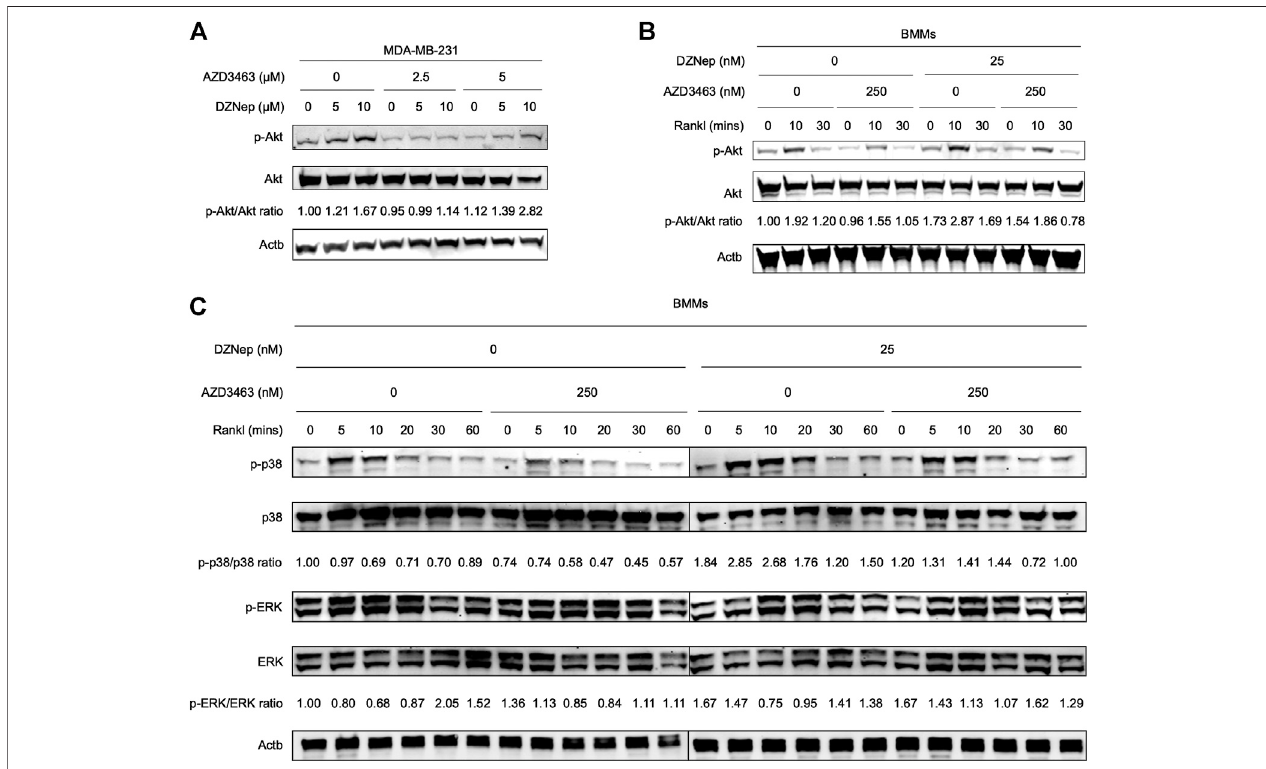
FIGURE 5 | Mechanistic analyses of DZNep and AZD3463 in breast cancer cells and during RANKL-induced osteoclastogenesis. (A) DZNep dose-dependently upregulated p-Akt (Ser473) protein but slightly downregulated pan-Akt protein in MDA-MB-231 cells. (B) DZNep upregulated p-Akt (Ser473) protein, but AZD3463 ameliorated this, in BMMs during RANKL-induced osteoclastogenesis. (C) During RANKL-induced osteoclastogenesis, DZNep upregulated p-p38 but AZD3463 ameliorated this, and there were no signi fi cant changes in ERK signaling.